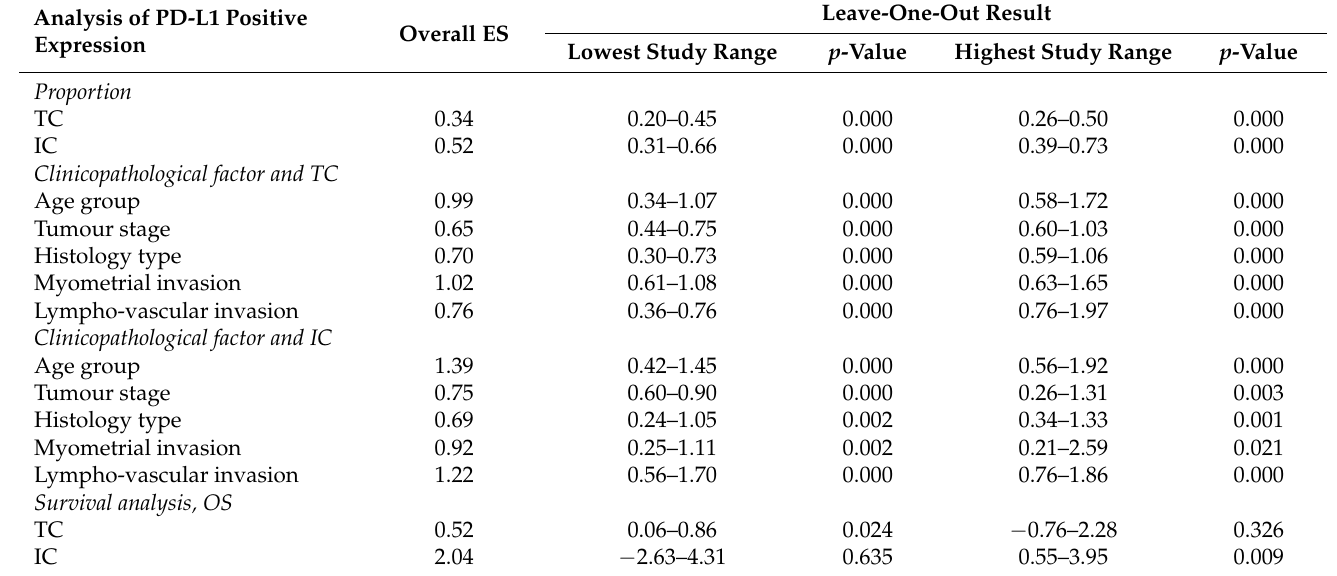
Table 3. The robustness check of the meta-analysis results using the leave-one-out